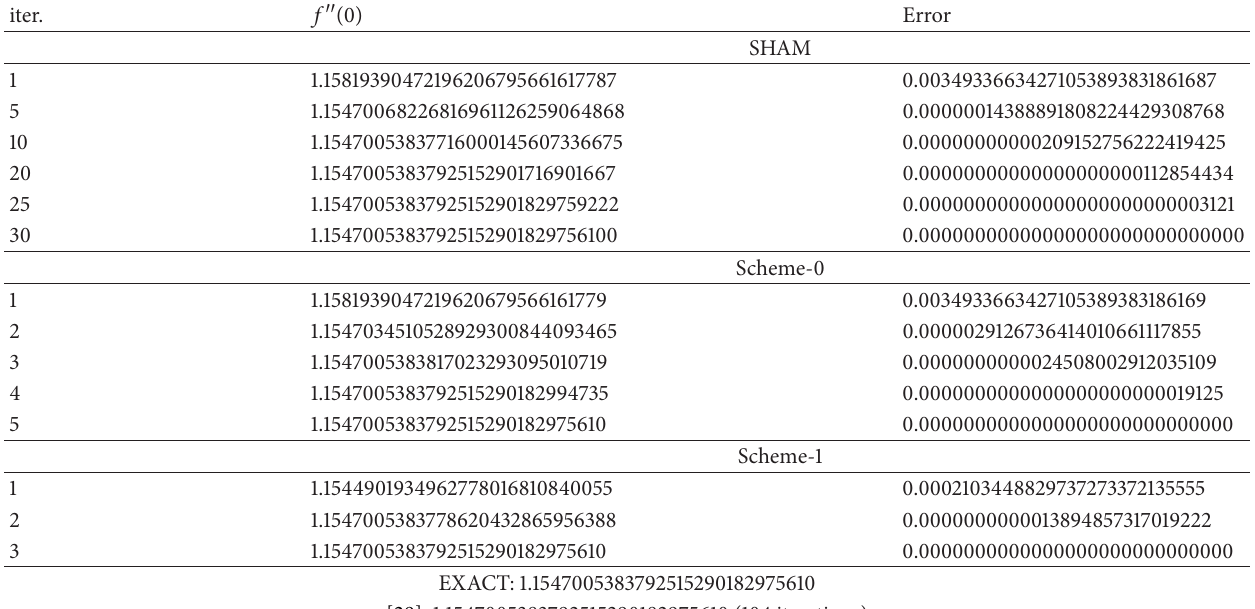
Table 2: Comparison between the computed values of the skin friction 𝑓 󸀠󸀠 (0) for the Pohlhausen flow (𝛽 = 0, 𝛽 1 = 1) .